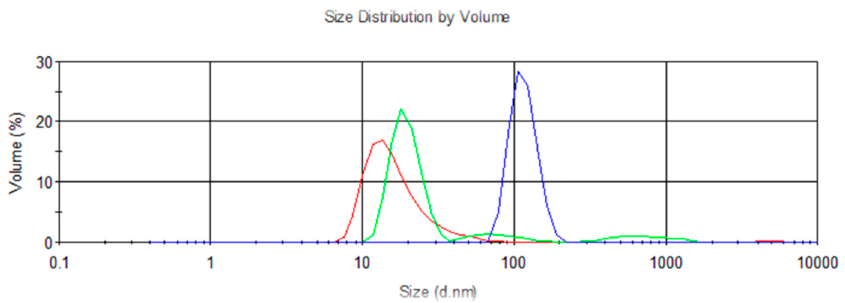
Figure 8. Measured particle-size distribution by volume: Red: MO + FF2, Green: NE + FF2, Blue: NE + FF1. Testing temperature 25 °C.